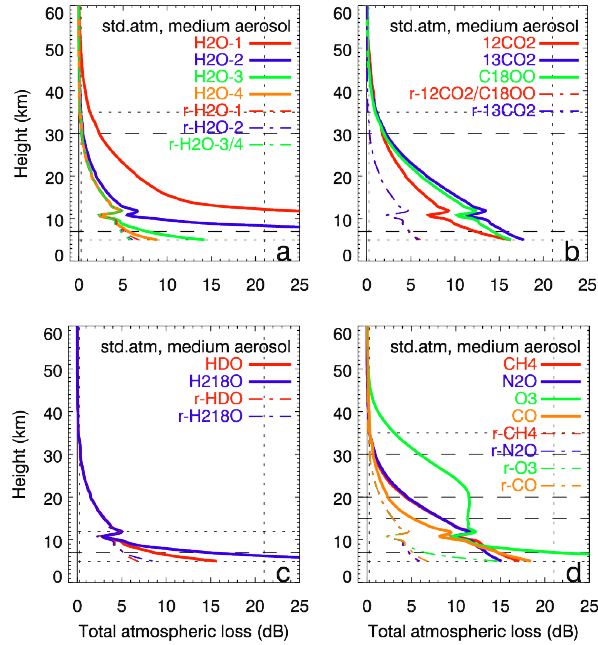
Fig. 9. Total atmospheric loss for the 13 absorption channels and the six reference channels listed in Table 1, for the FASCODE STD atmosphere and medium aerosol load. The layout of the panels is the same as in Fig. 4.